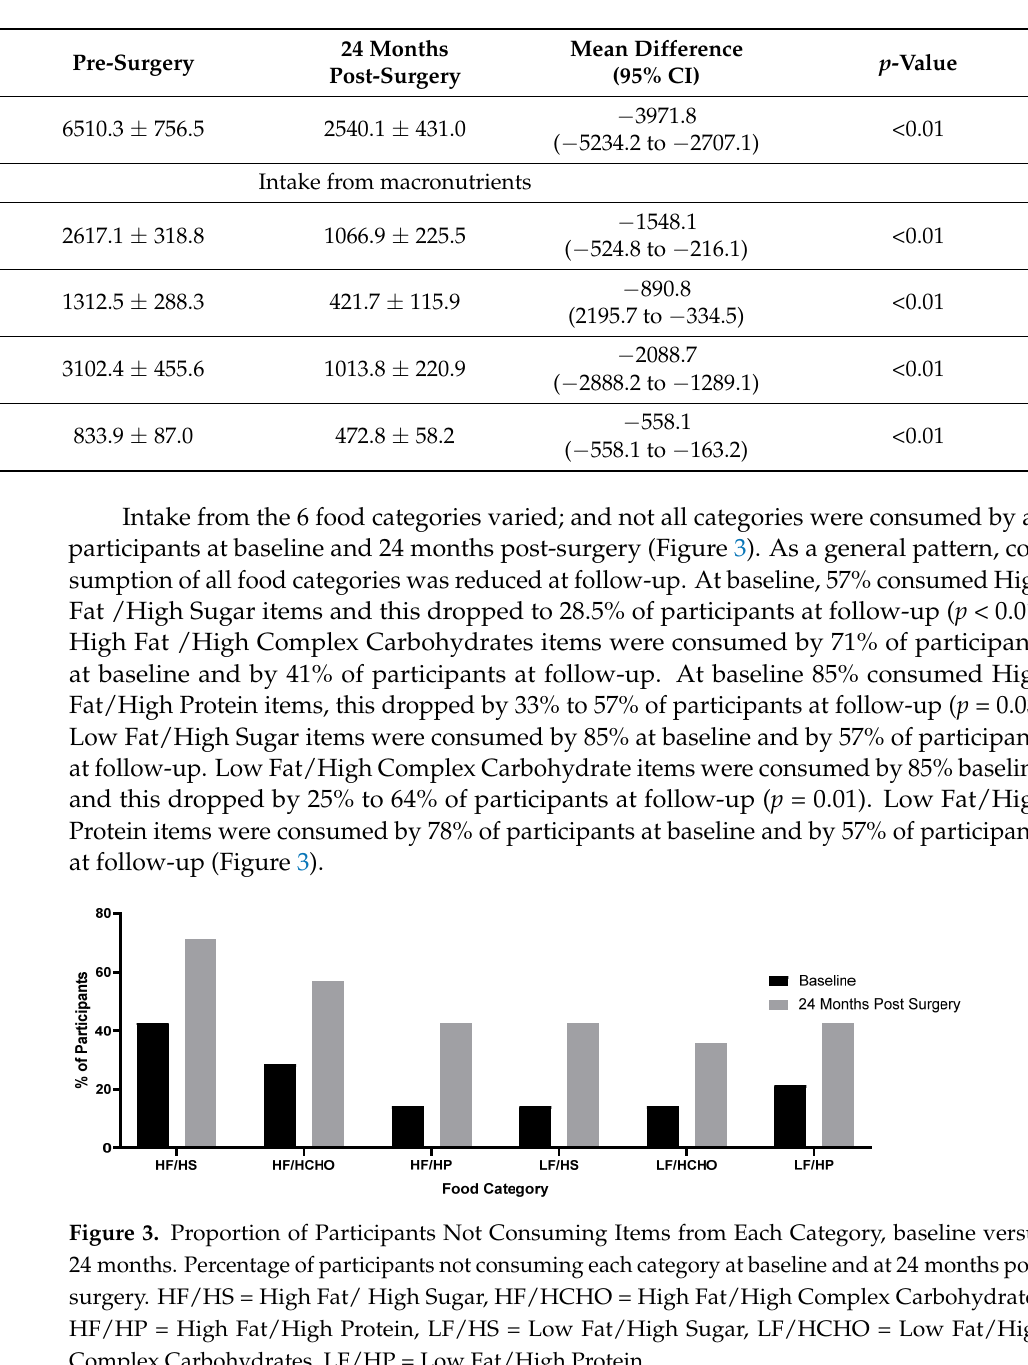
Table 3. Absolute measures of total and macronutrient specific intake at buffet meal. Data presented as mean ± standard error.